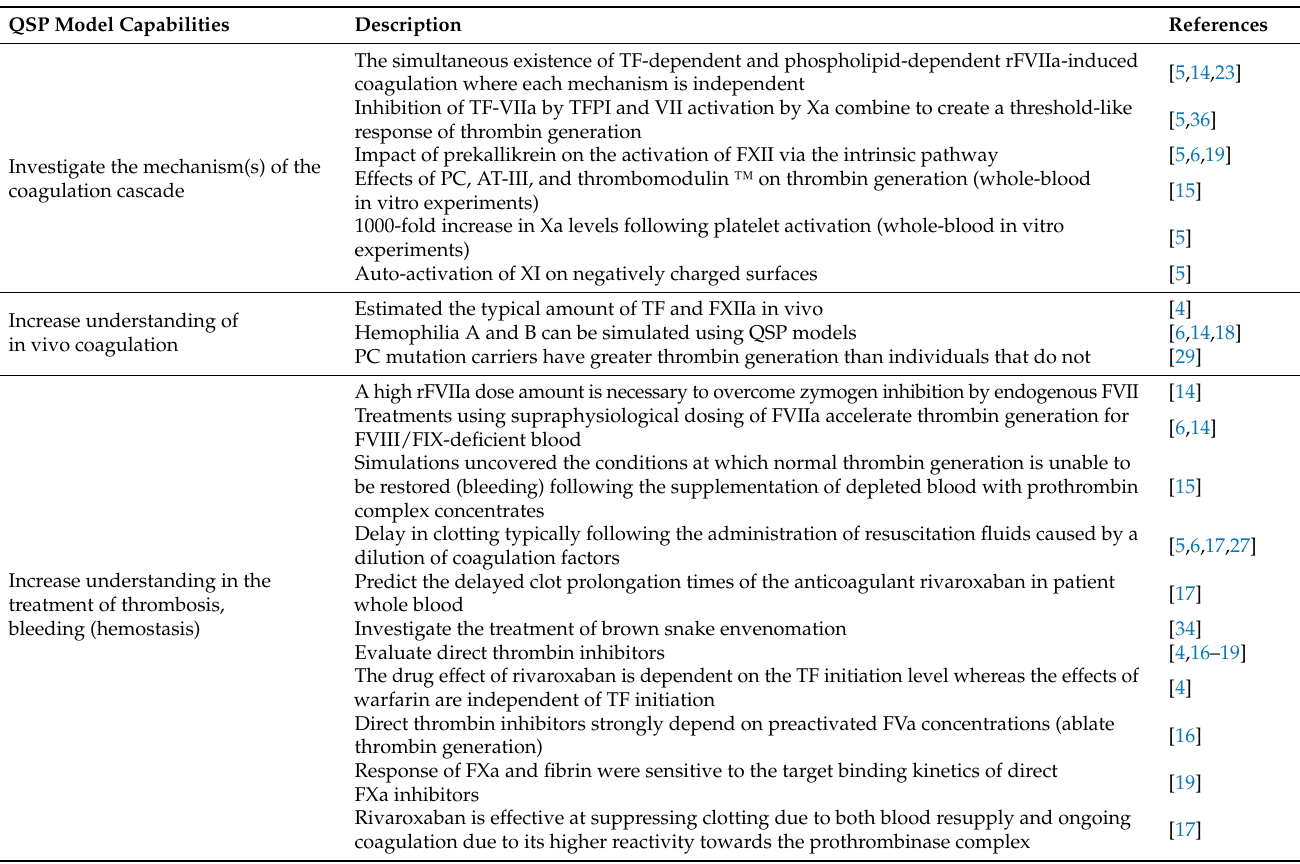
Table 1. QSP models offer insights into the mechanisms of the coagulation cascade, in vivo coagula- tion, and treatment effects for thrombosis and